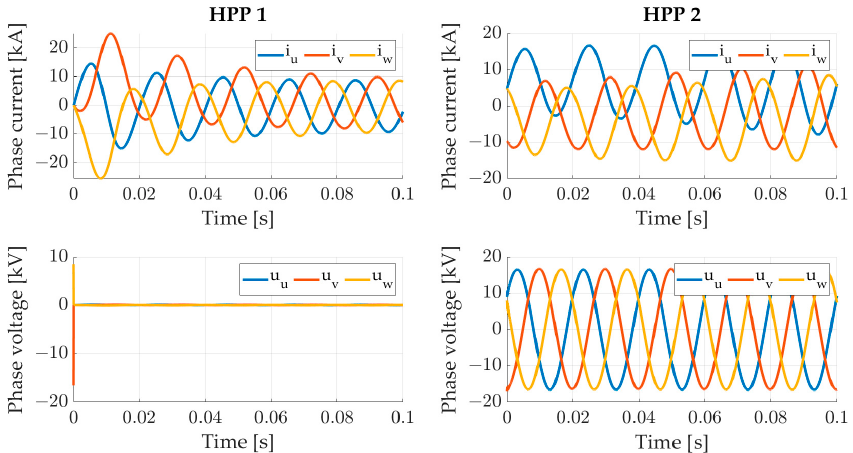
Figure 15. Phase currents and voltages in generators built in the model.